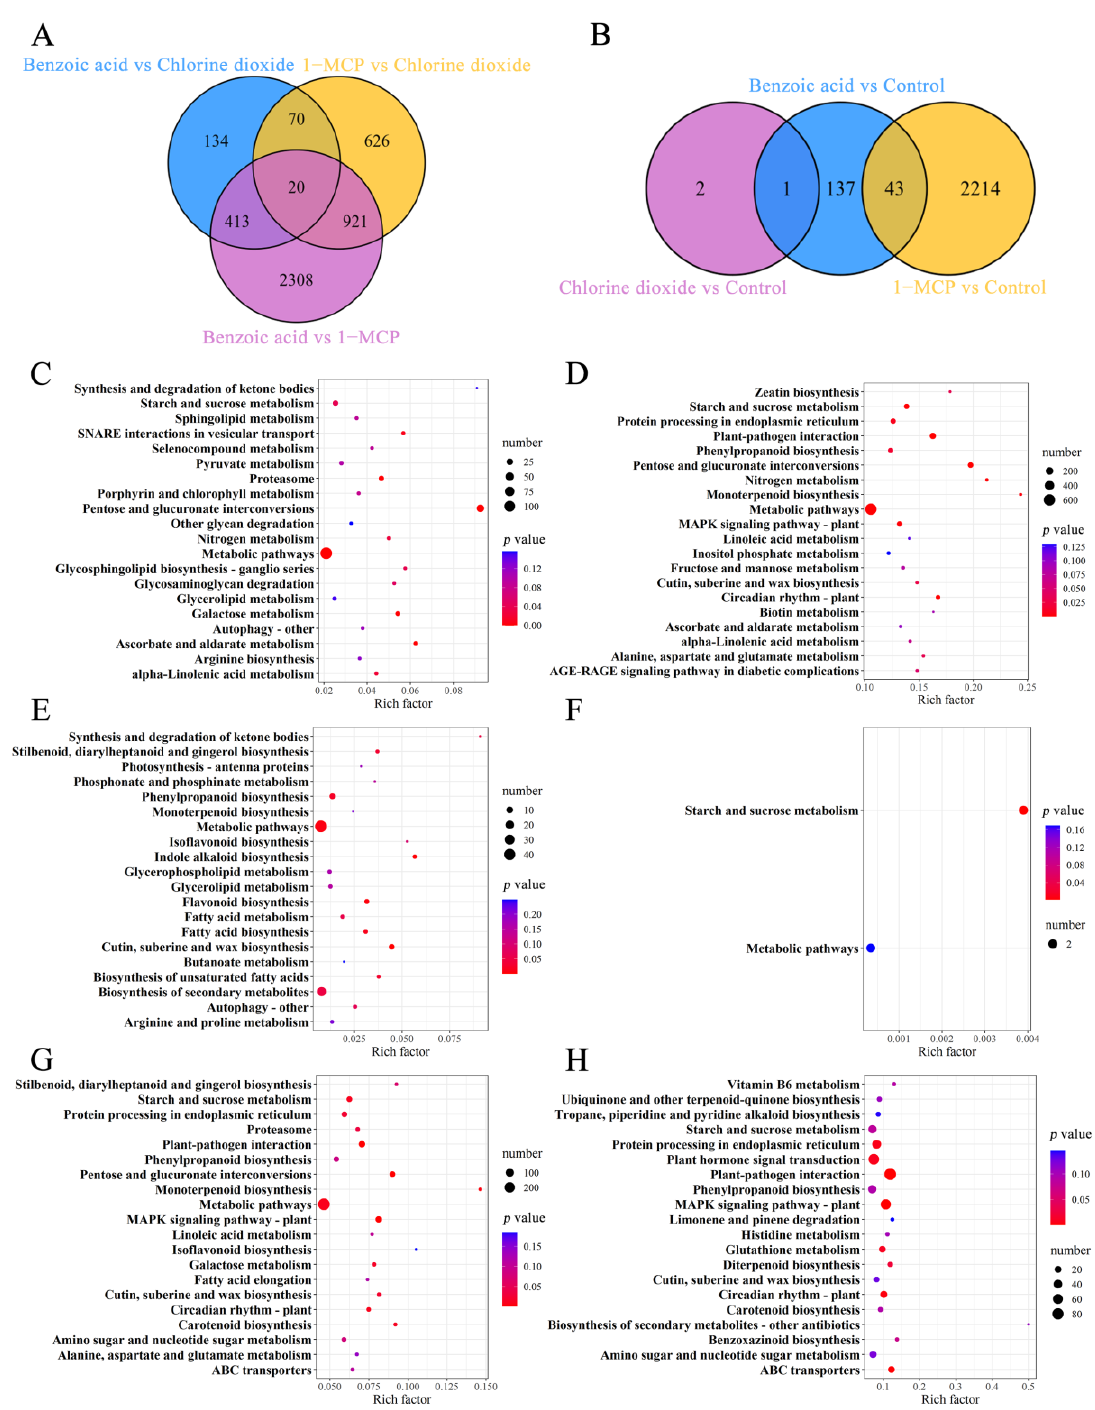
Figure 3. Venn diagram revealing DEGs numbers from different groups ( A , B ). The numbers of DEGs and significantly enriched KEGG pathways in different combinations of Benzoic acid vs. Chlorine dioxide ( C ), Benzoic acid vs. 1-MCP ( D ), Benzoic acid vs. Control ( E ), Chlorine dioxide vs. Control ( F ), 1-MCP vs. Chlorine dioxide ( G ), 1-MCP vs. Control ( H ). The y -axis and x -axis are KEGG pathways and enrich factors, respectively. Low and high p values are expressed by the red circle and the blue circle, respectively. The area of a circle is the DEG